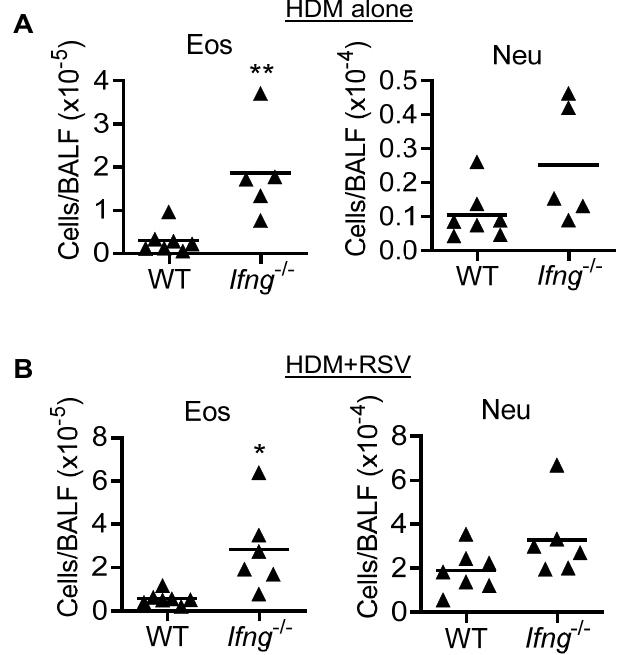
Figure 5. IFN- γ is necessary for limiting HDM-induced eosinophil infiltration regardless of RSV infection. Numbers of airway eosinophils and neutrophils in C57BL/6 WT and Ifng − / − mice during ( A ) HDM-induced asthma alone and ( B ) RSV infection of HDM-induced asthmatic mice. * p < 0.05, ** p < 0.01, one-way ANOVA with Tukey’s multiple comparisons’ test. Data shown are representative of at least two independent experiments.